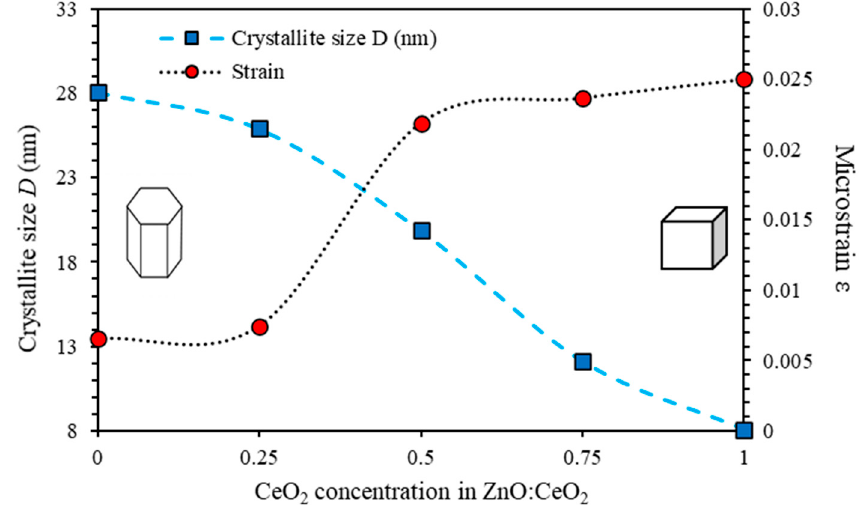
Figure 3. The crystallite size, D and the microstrain ε of ZnO:CeO 2 mixed oxides thin films as a function of CeO 2 concentration calculated using Williamsons Hall equation.